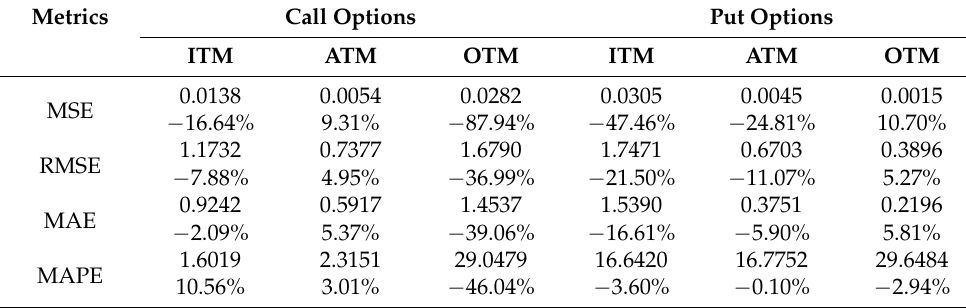
Table 7. Pricing error of LSTM with realized skewness and realized